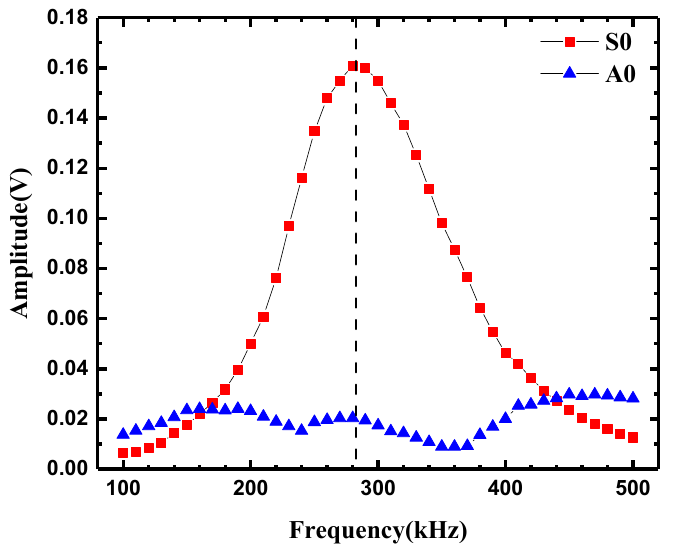
Figure 3. Lamb wave mode-tuning curve for a 2 mm-thick aluminum plate excited by a 1 mm-thick PZT